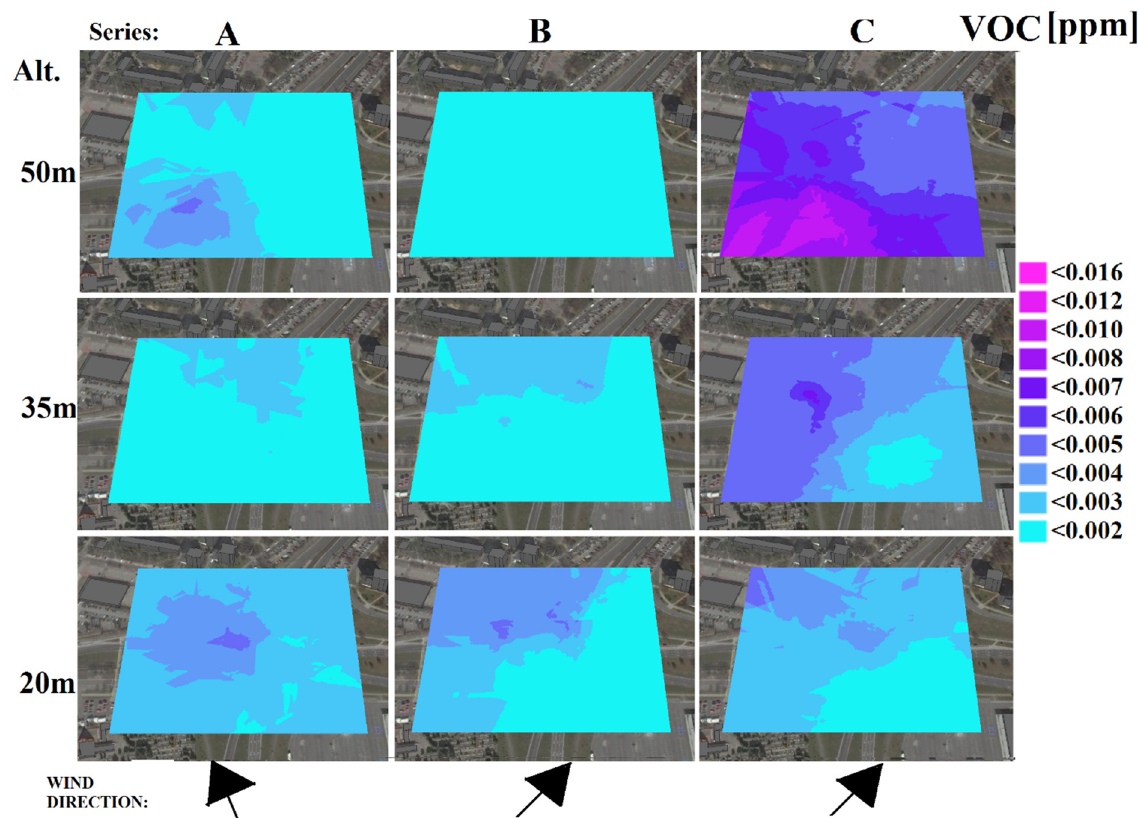
Figure 14. Spatial distribution of VOC pollution at the altitude of 20, 35, and 50 m for three measurement series in the area of the street intersection.